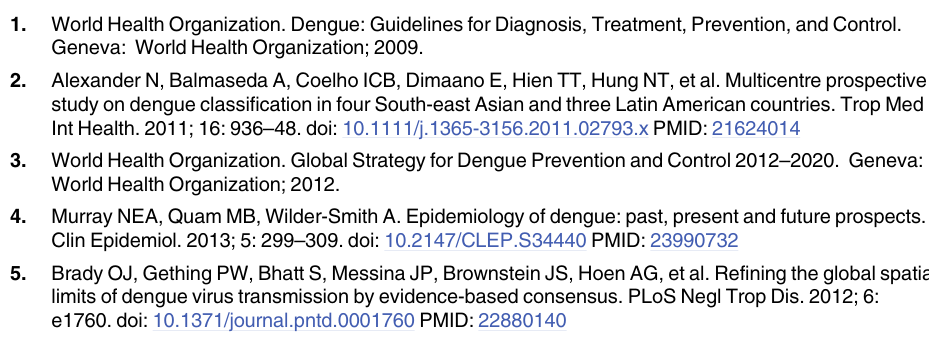
S1 Table. Characteristics of the control group of the CYD14 study, described by age group, site, and the numbers of dengue and associated clinical episodes occurring during the time- frame of the study. S2 Table. Dengue surveillance data from the areas in which the CYD14 clinical trial was conducted, over the period of study and population